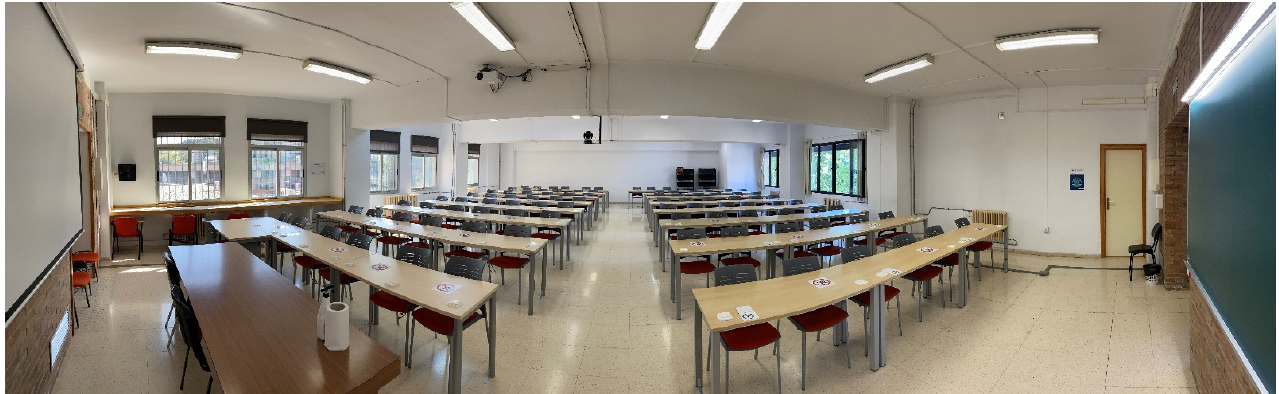
Figure 2. Selected classroom.